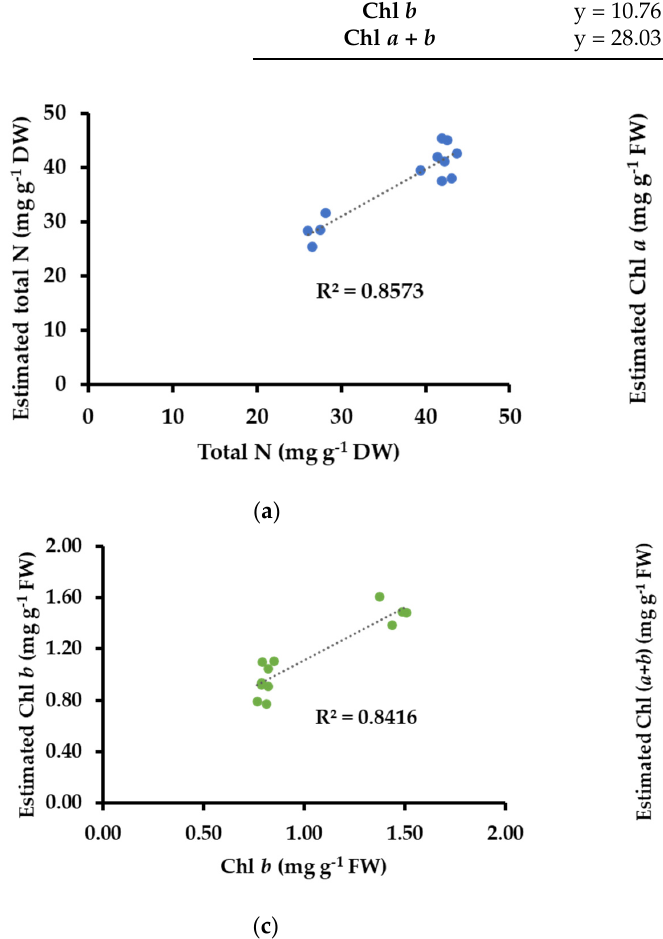
Figure 2. Visualization of the different correlations studied in P. obtusifolia. ( a ) Total N (mg g − 1 DW), ( b ) Chl a (mg g − 1 FW), ( c ) Chl b (mg g − 1 FW), ( d ) Chl ( a + b ) (mg g − 1 FW).